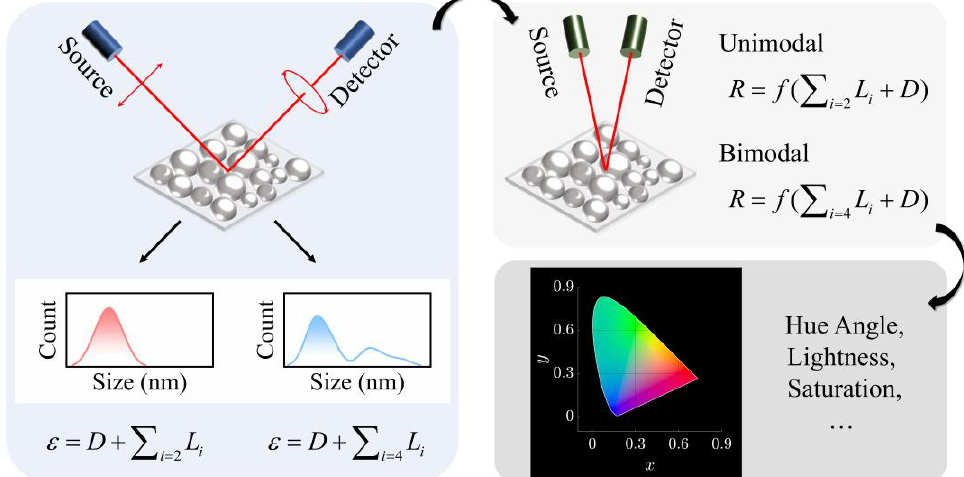
Figure 1. Flowchart of the ellipsometry-assisted interpretation on reflection and colorimetry of nanosized indium particles.